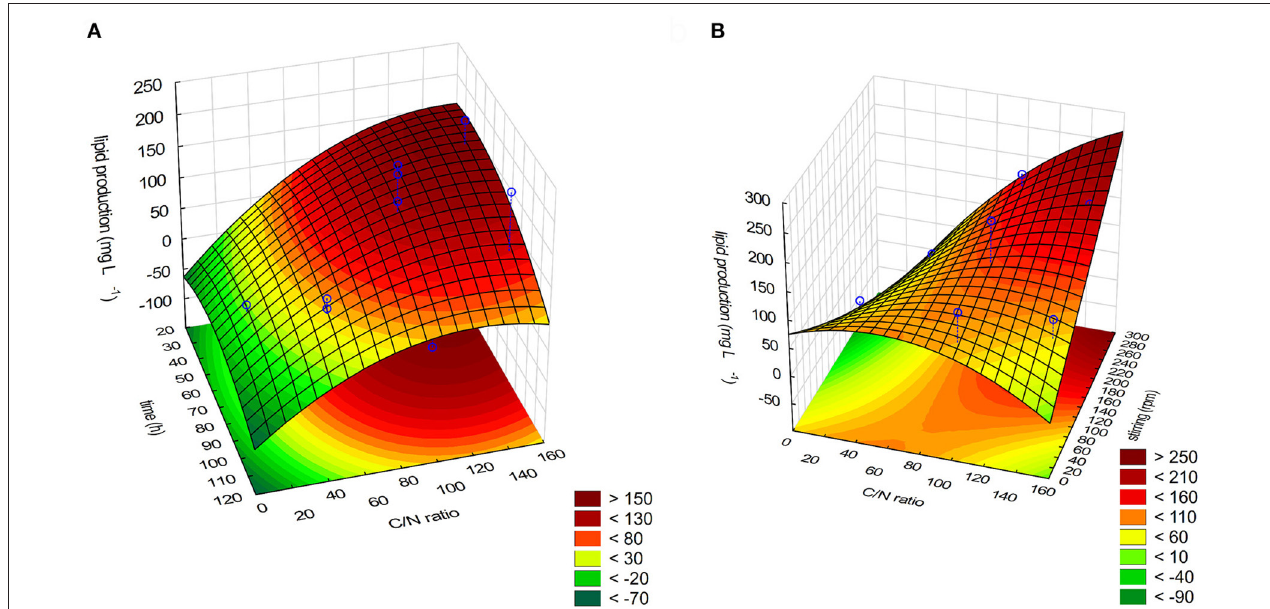
FIGURE 4 | (A) Response surface plot for the effect on time cultivation, C/N ratio and their mutual effect on the lipid production in M. guilliermondii BI281A. (B) Response surface plot for the effect on C/N ratio, stirring (rpm) and their interaction on the lipid production for M. guilliermondii BI281A.